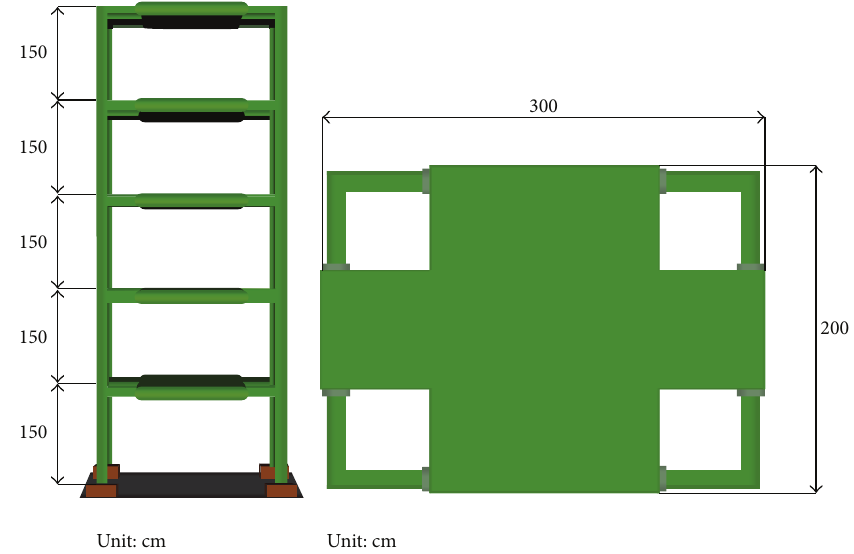
Figure 5: Elevation and layout of the benchmark model.